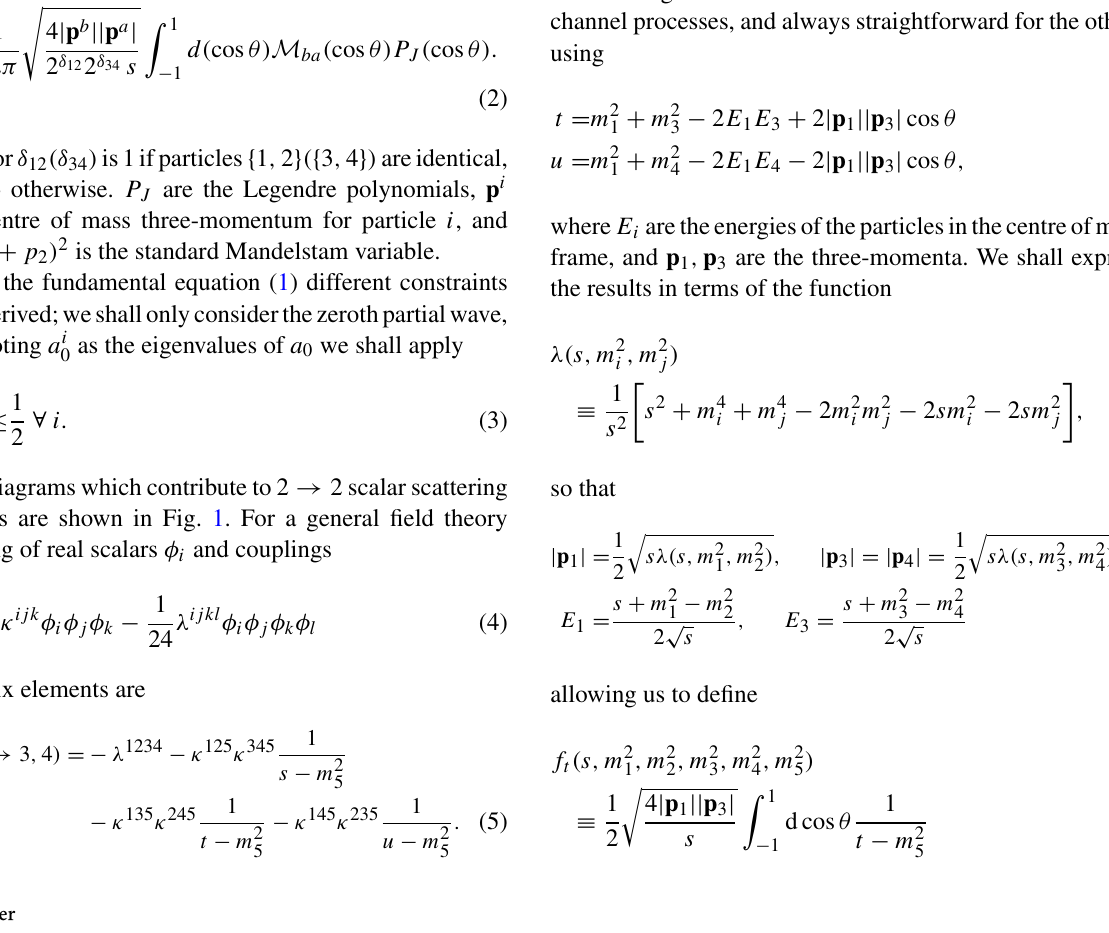
Fig. 1 The four topologies contributing to 2 → 2 scalar scattering √ s . In the approximation of processes at finite point interaction